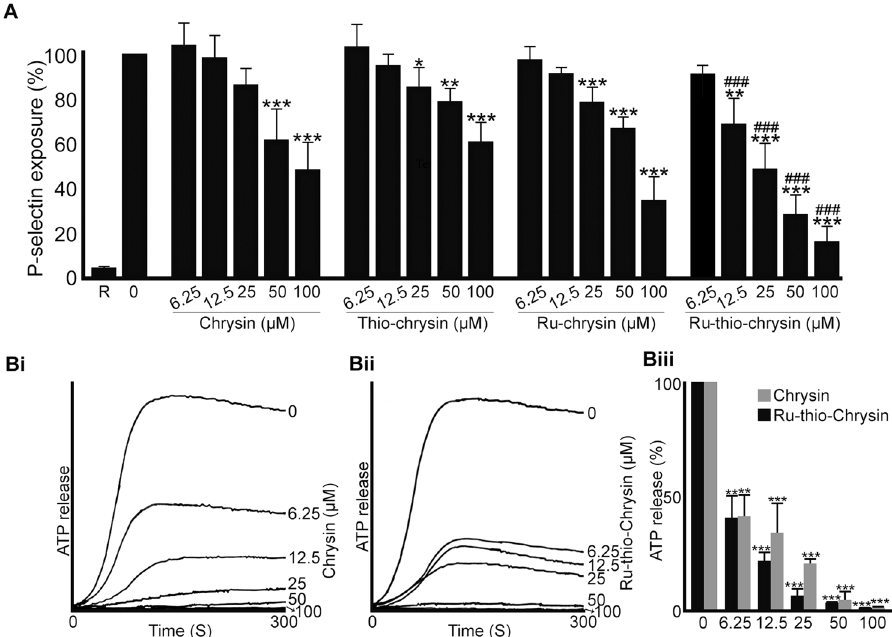
Figure 5. Chrysin and its derivatives affect granule secretion in platelets. ( A ) human platelet-rich plasma was treated with vehicle [0.1% (v/v) DMSO] or diverse concentrations of chrysin, thio-chrysin, Ru-chrysin and Ru-thio-chrysin for 5 minutes prior to the addition of 0.5 μ g/mL CRP-XL and incubation of 20 minutes at room temperature. The level of P-selectin (as a marker for α -granule secretion) was quantified using PECy5-labelled anti-human P-selectin antibodies by flow cytometry. The level of fluorescence obtained with vehicle control was taken as 100% to calculate the extent of inhibition in chrysin and its derivatives-treated samples. R represents ‘resting’ platelets. Cumulative data represent mean ± S.D. (n = 4). ( B ) human washed platelets were mixed with luciferin-luciferase reagent for two minutes followed by incubation with a vehicle control [0.1% (v/v) DMSO] or different concentrations of chrysin ( i ) or Ru-thio-chrysin ( ii ) for another 5 minutes. Platelets were then activated with 0.5 μ g/mL CRP-XL and the ATP release was monitored for 5 minutes by lumi-aggregometry. The traces shown are representative of three separate experiments. The maximum ATP release obtained with vehicle control was taken as 100% to calculate the level of inhibition in chrysin and Ru-thio-chrysin treated samples ( iii ). Cumulative data represent mean ± S.D. (n = 3). * Indicates significance with respect to controls and # indicates significance with respect to the respective chrysin concentrations; p values shown ( * p < 0.05, ** p < 0.01 and *** ,### p < 0.001) are as calculated by one-way ANOVA using Graphpad